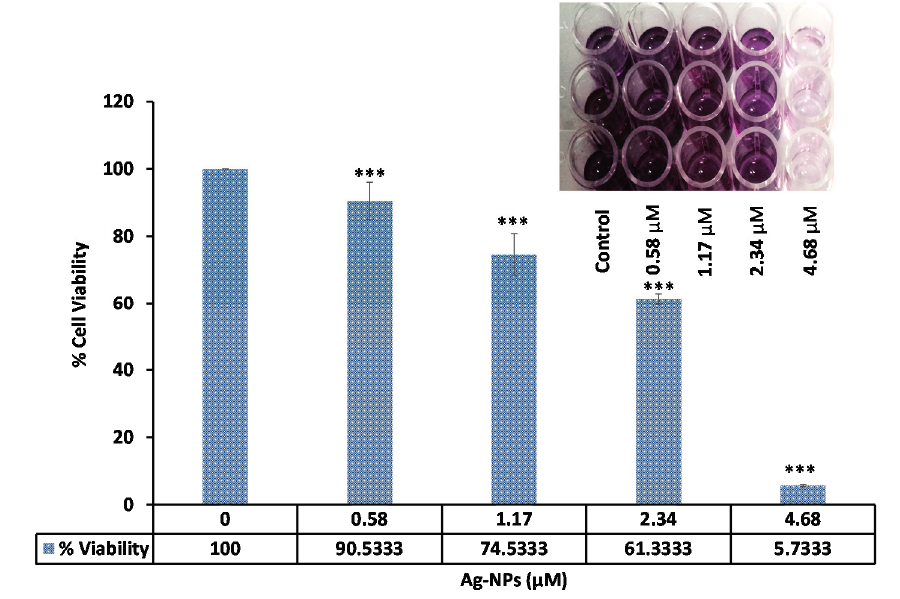
Figure 9 . Cytotoxic effect of biosynthesized Ag-NPs on the growth of HepG2. A dose-dependent reduction of cell viability was observed at 570 nm. *** p <